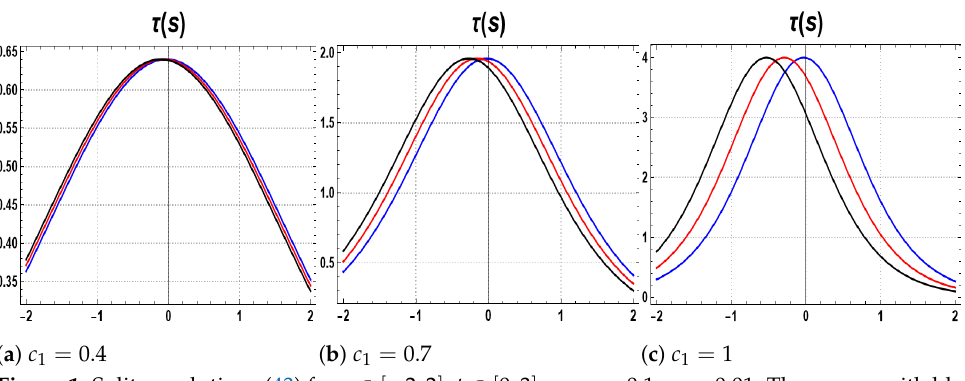
Figure 1. Soliton solutions (43) for s ∈ [ − 2,2 ] , t ∈ [ 0,3 ] , µ 0 = − 0.1, c 2 = 0.01. The curves with blue, red, and black colors represent the soliton solutions at t = 0.1,1.4,2.6, respectively.